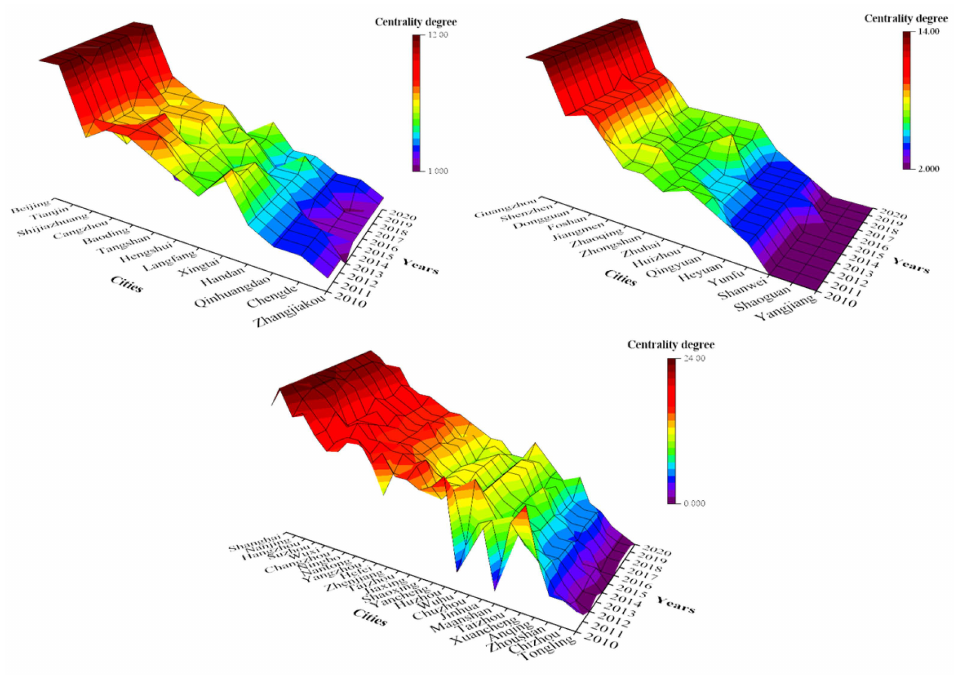
Figure 6. Cities’ centrality degrees of the housing prices’ association network in the BTHUR ( upper left ), the PRDUR ( upper right ), and the YRDUR ( bottom ) from 2010 to